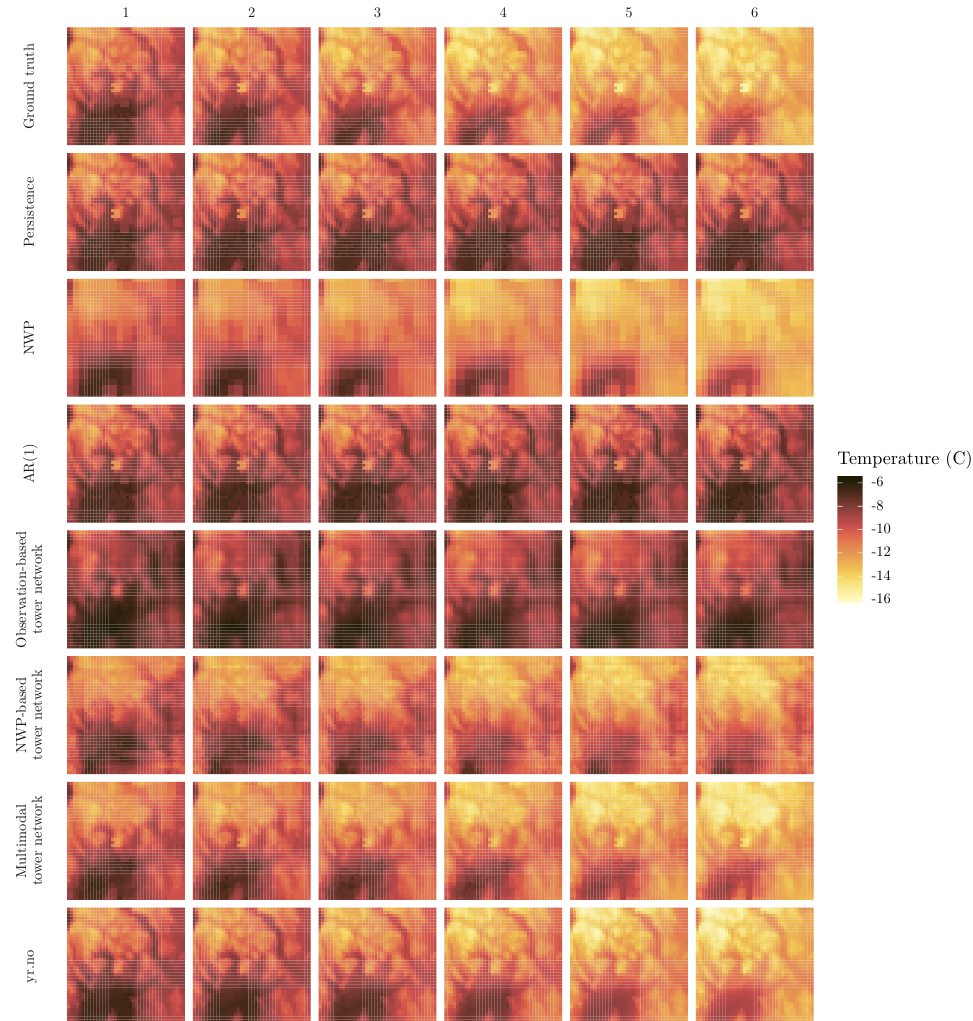
Figure 5. Example of temperature forecasts from the different models with the ground truth for reference. Each row corresponds to a model, and each column to an